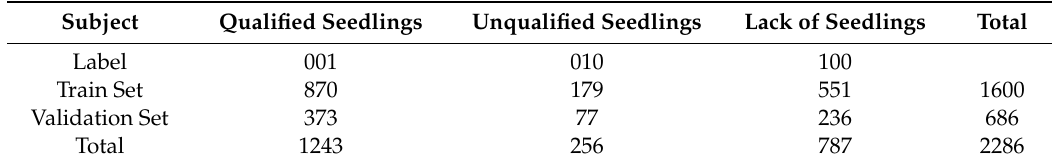
Table 1. Sample data distribution.